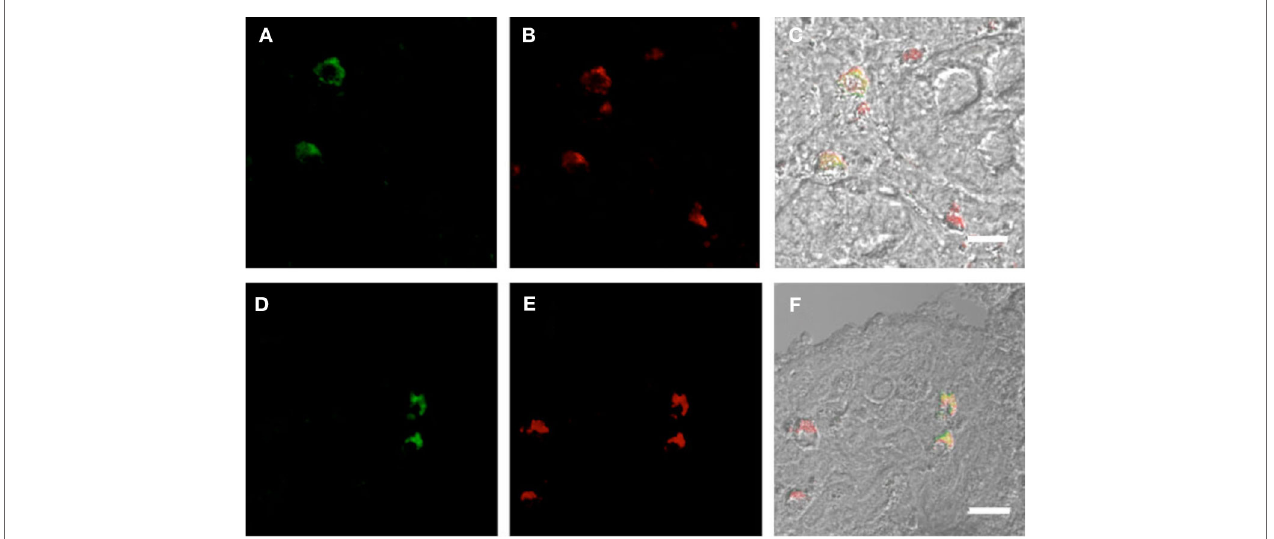
FigUre 3 | Duodenum biopsies of hiV/aiDs cases and controls evaluated for coexpression of cD303 (green) and cD4 (red) . Bar represents 20 μ m. (a) HIV case duodenum biopsies probed with a monoclonal FITC-anti-CD303 antibody. (B) HIV case duodenum biopsies probed with a monoclonal PE-anti-CD4 antibody. (c) HIV case duodenum biopsies DIC image merged with (a,B) . (D) Control duodenum biopsies probed with a monoclonal FITC-anti-CD303 antibody. (e) Control duodenum biopsies probed with a monoclonal PE-anti-CD4 antibody. (F) Control duodenum biopsies DIC image merged with (D,e)